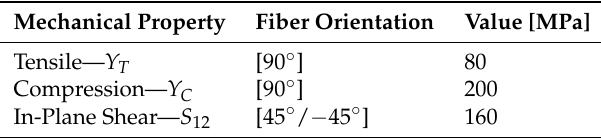
Table 7. Experimental data for AS4-PEEK